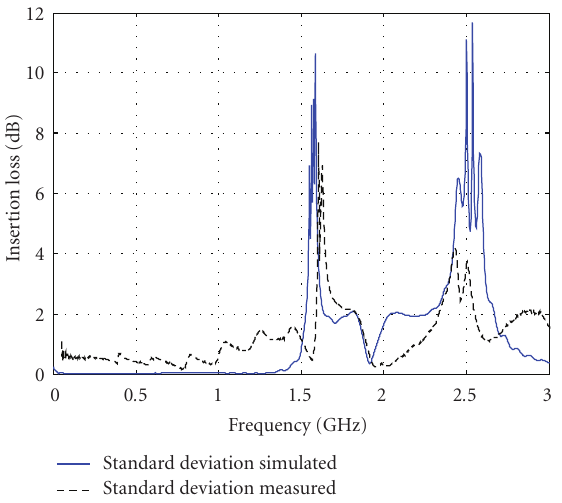
Figure 3: Standard deviation simulated and measured.